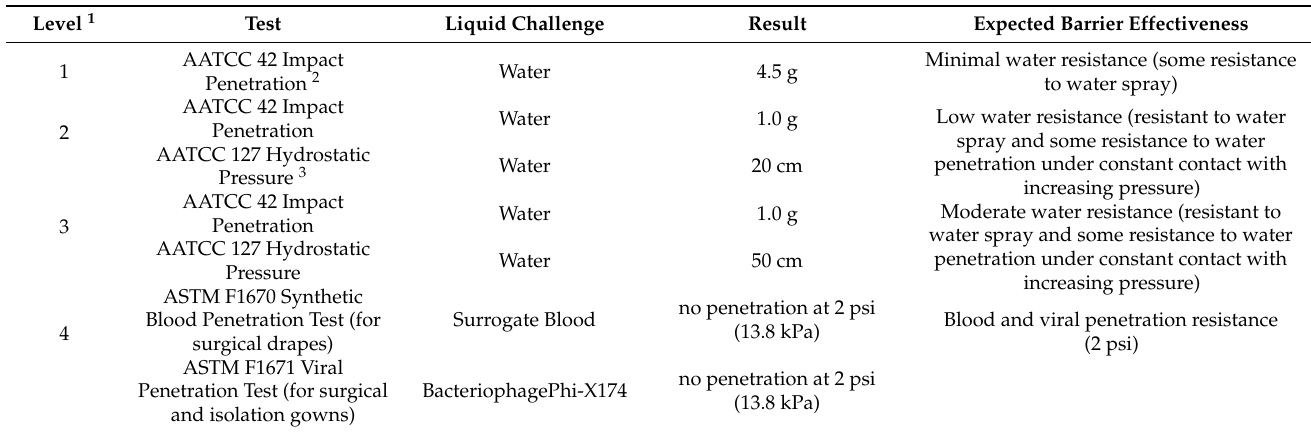
Table 1. ANSI/AAMI PB 70:12 classification of barrier performance of surgical gowns